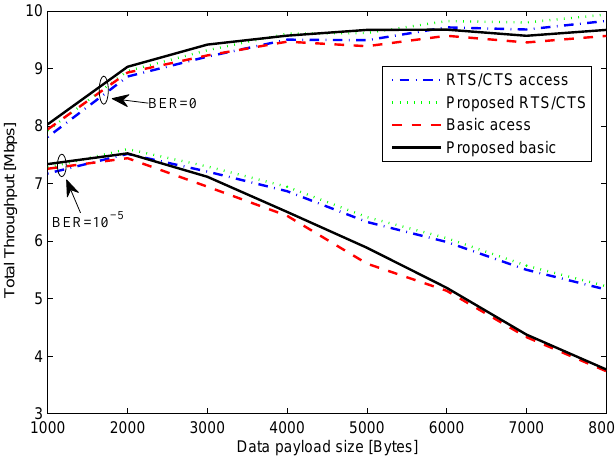
Figure 5. Throughput for n = 10, r’ = 1 Mbps, r = 11 Mbps.